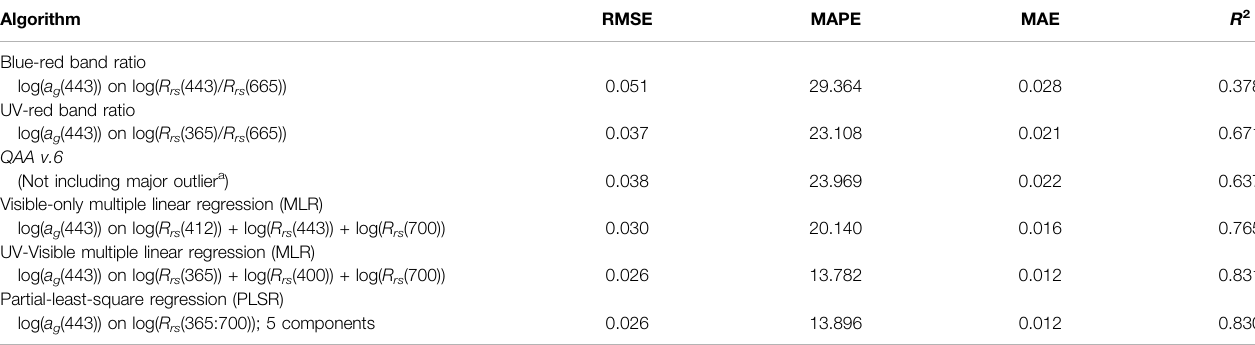
TABLE 2 | Summary statistics associated with the performance comparison of the six a g (443) algorithms (see also Figure 8 ). Statistics include root mean squared error (RMSE), mean average percent error (MAPE), mean absolute error (MAE), and R-squared for each algorithm. Algorithm RMSE MAPE